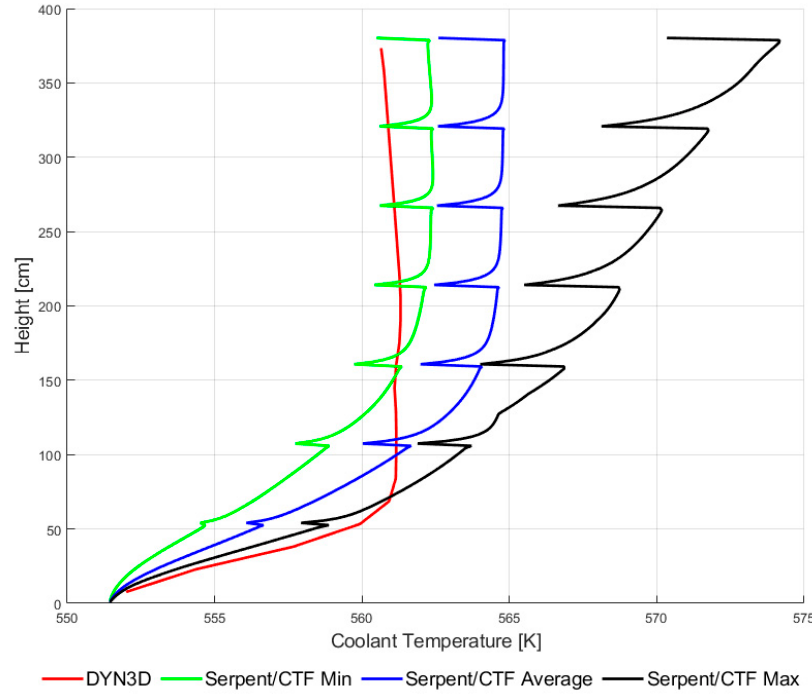
Figure 20. Subchannel temperature (K) comparison between DYN3D and CTF.